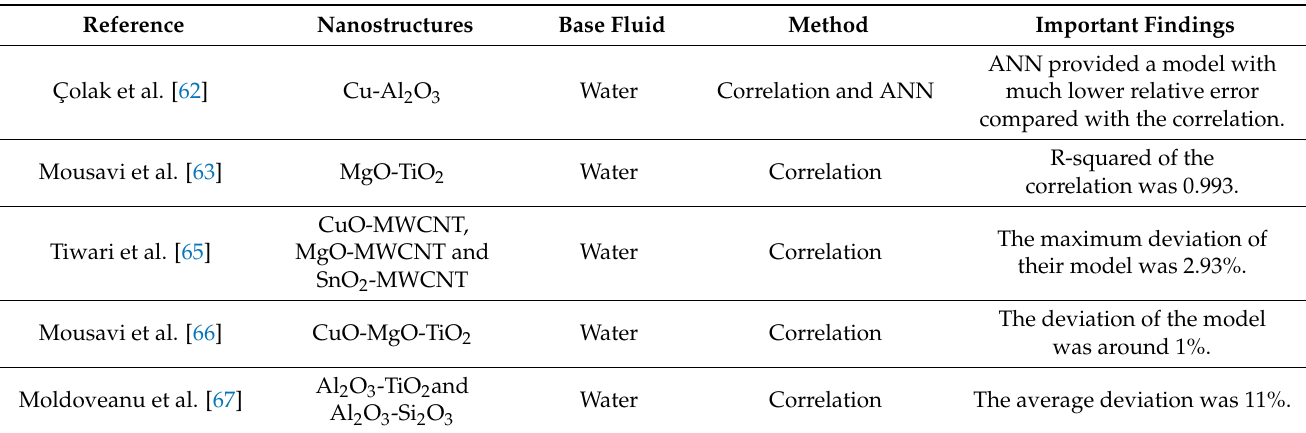
Table 4. Proposed models for the SH of hybrid